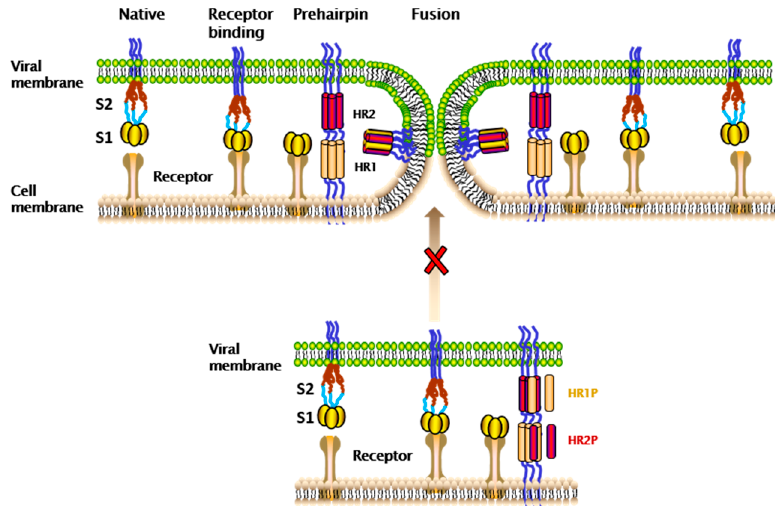
Figure 1. Model of membrane fusion mediated by coronavirus (CoV) spike (S) protein and the mechanism of heptad repeat 1 peptide (HR1P) and heptad repeat 2 peptide (HR2P). In the native state, the fusion peptide (FP), heptad repeat 1 (HR1) and heptad repeat 2 (HR2) domains in the S2 subunit are shielded by the S1 subunit. In the receptor-binding state, the S1 subunit binds with receptor on the target cell surface. In the pre-hairpin state, the S1 subunit dissociates, and FP in the S2 subunit is inserted into the target cell membrane, resulting in formation of the 6-HB fusion core by HR1 and HR2 and final fusion between the cell and virus membranes. HR1P and HR2P peptides can interact with the viral HR2 and HR1 domains, respectively, to block viral fusion core (6-HB) formation and inhibit viral and cellular membrane fusion. The “cross” and “arrow” means that the peptide HR1P or HR2P can block the viral gp41 6-HB-mediated membrane fusion process.